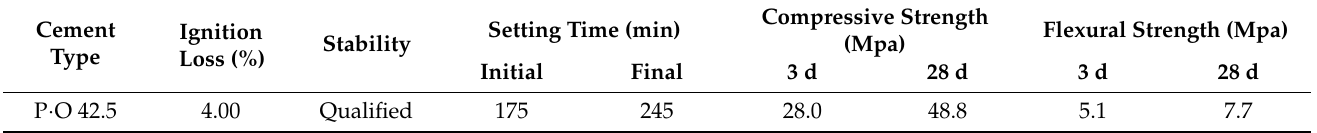
Table 1. Physical and mechanical properties of